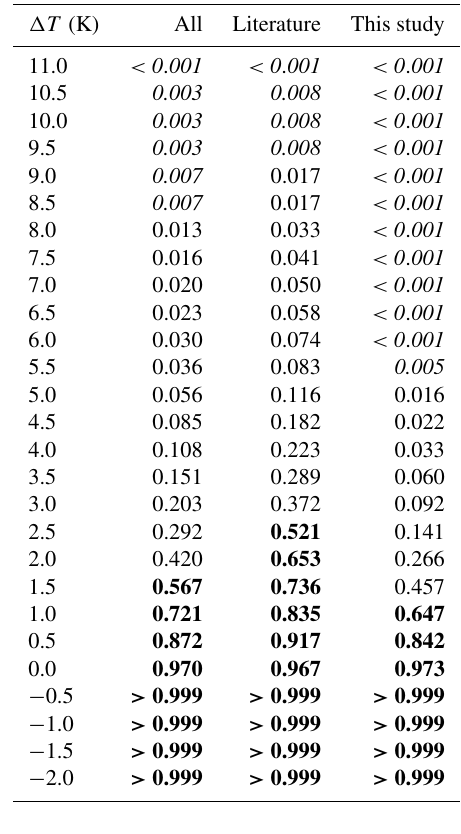
Table 3. Empirical probabilities Pr ( ≤ (cid:49)T ) to relate a future tem- perature drop during an eclipse to values previously published in the literature and in this paper. Bold figures are above the median, and figures in italics are below the 10% percentile of the empiri- cal probability distribution. The sign convention uses positive (cid:49)T if temperature gets colder during the occulation